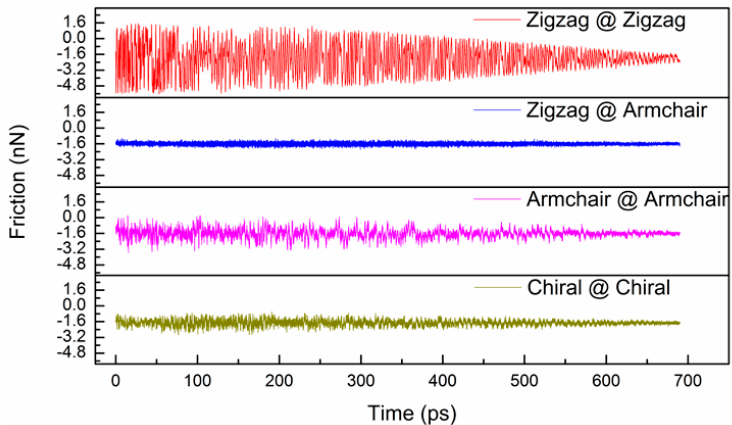
Figure 2. Variation of friction force between shells with time for four DWCNT types.